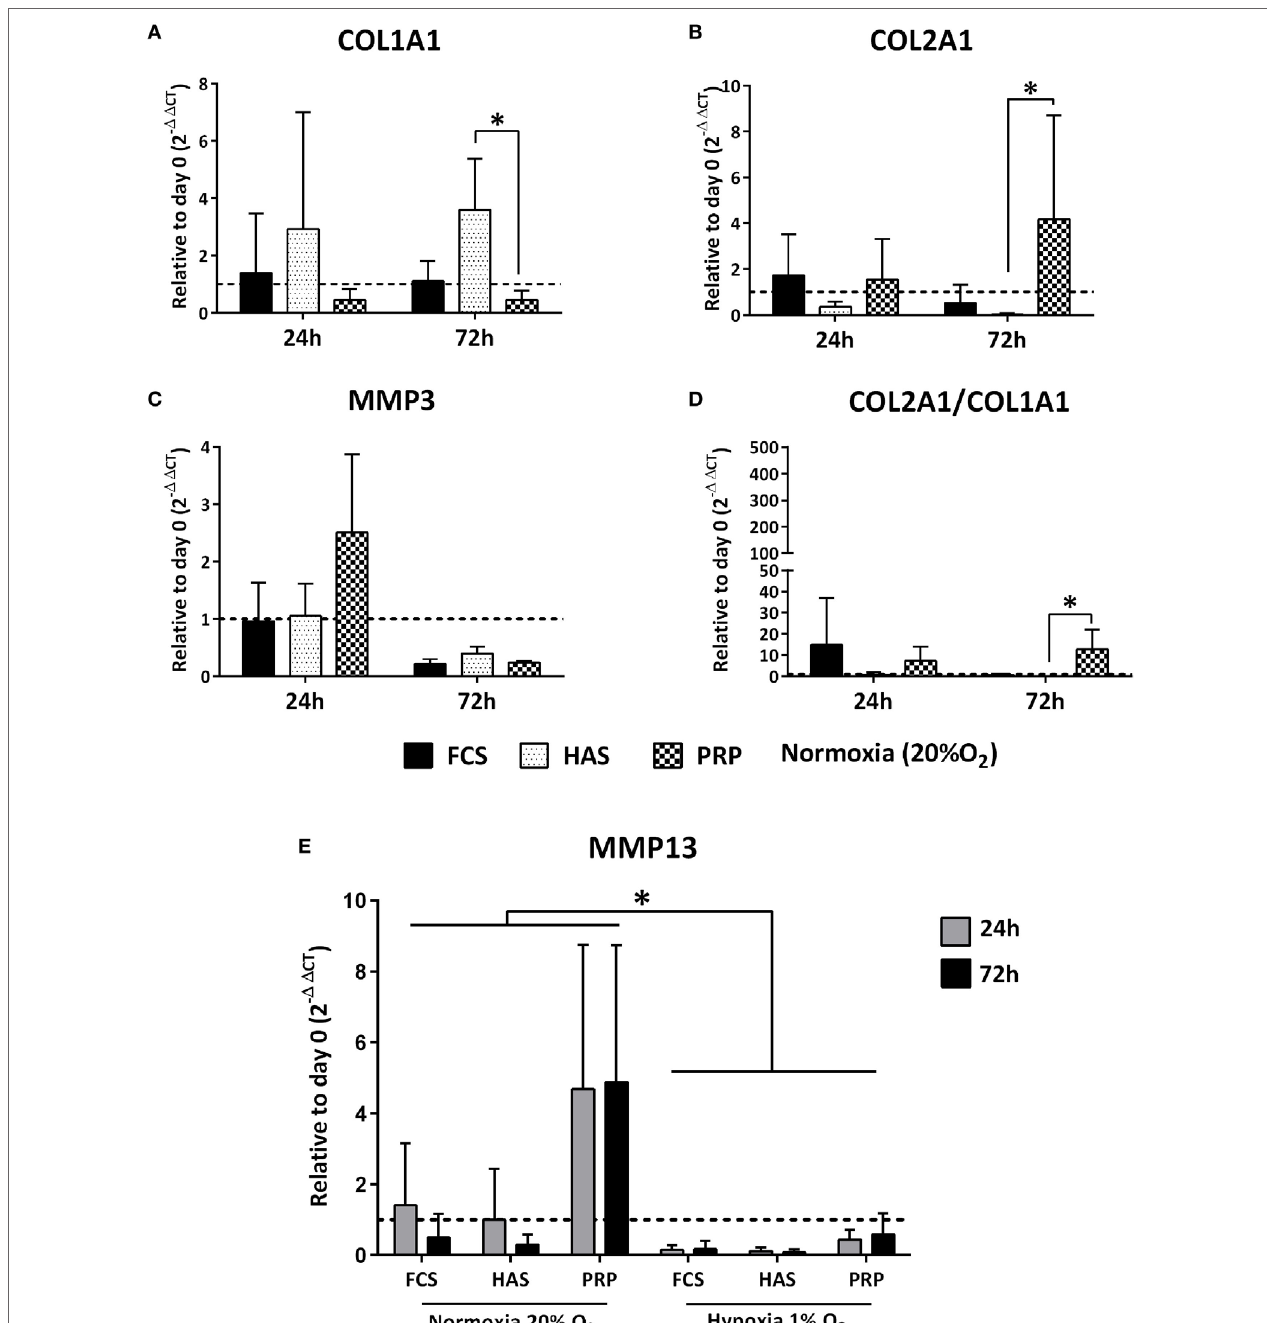
FigUre 3 | Differences in relative expression of chondrogenic markers COL1A1, COL2A1, MMP3 (a–c) , and the differentiation index (D) depicted to day 0 control under normoxic (20% O 2 ) conditions. Matrix metalloproteinase 13 (MMP13) expression significantly downregulated under hypoxia (1% O 2 ) than in normoxia (20% O 2 ) (e) as determined by reverse transcriptase quantitative real-time PCR of OA chondrocytes cultured in FCS, hyperacute serum (HAS), or platelet-rich plasma (PRP). Significant difference at * p < 0.05; n = 3 biological